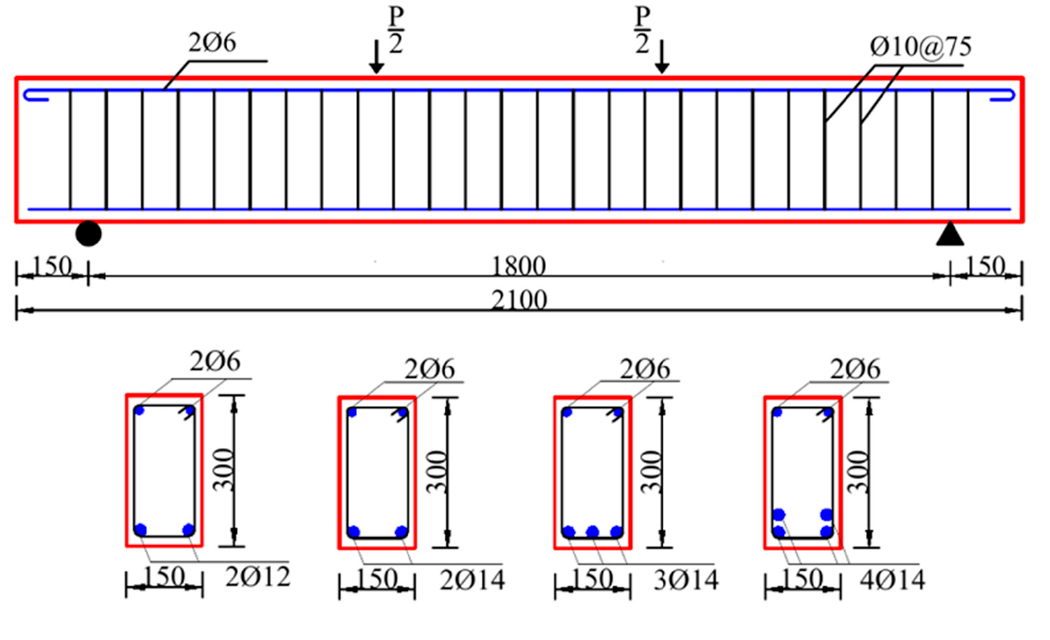
Figure 3. Specimen geometry and reinforcement.